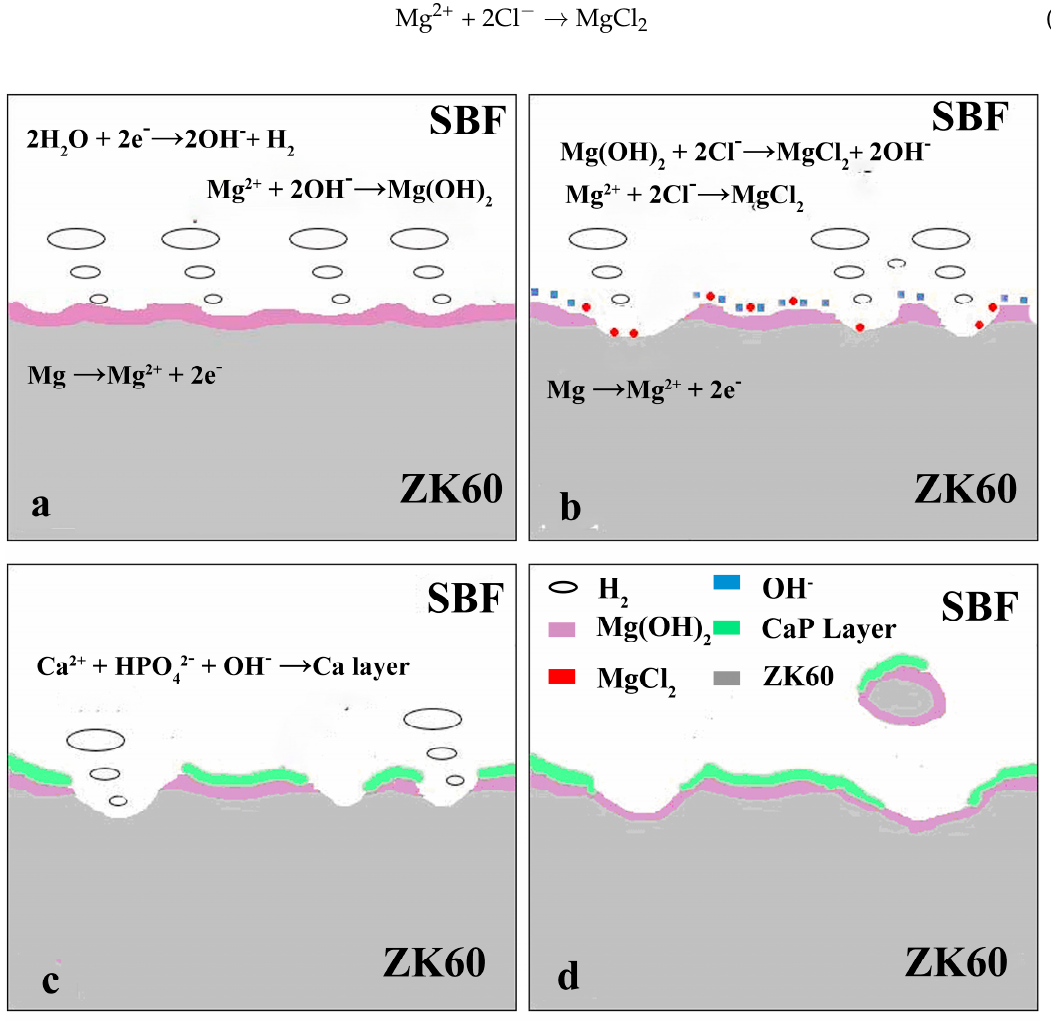
Figure 12. Degradation models of the uncoated samples upon immersion in the SBF. ( a ) uniform corrosion stage, ( b ) localized corrosion stage, ( c ) Ca-P formation stage, and ( d ) local decomposition